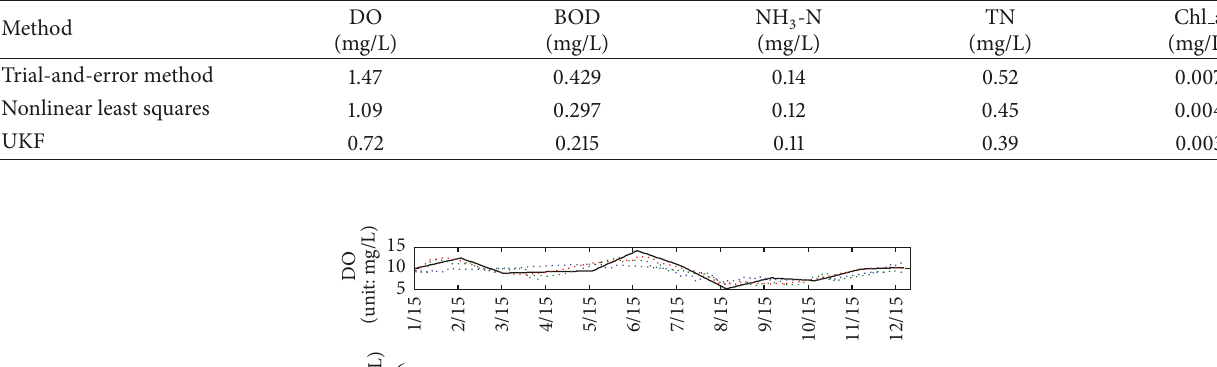
Table 2: RMSE values of each water quality index obtained by different methods.